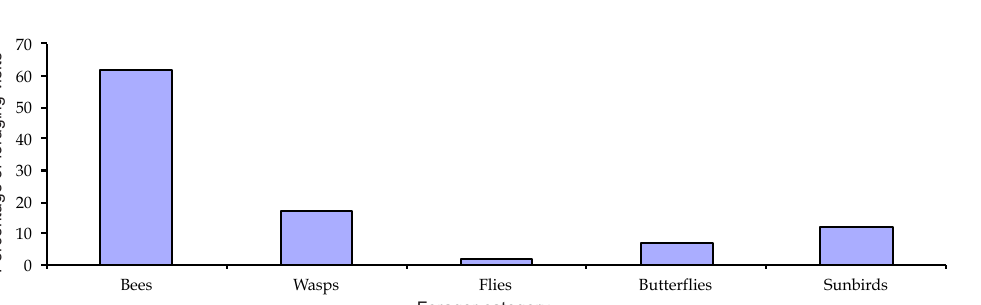
Figure 5. Hourly foraging activity of sunbirds on Boswellia ovalifoliolata Figure 5 : Hourly foraging activity of sunbirds on Boswellia ovalifoliolata Figure 5 : Hourly foraging activity of sunbirds on Boswellia ovalifoliolata